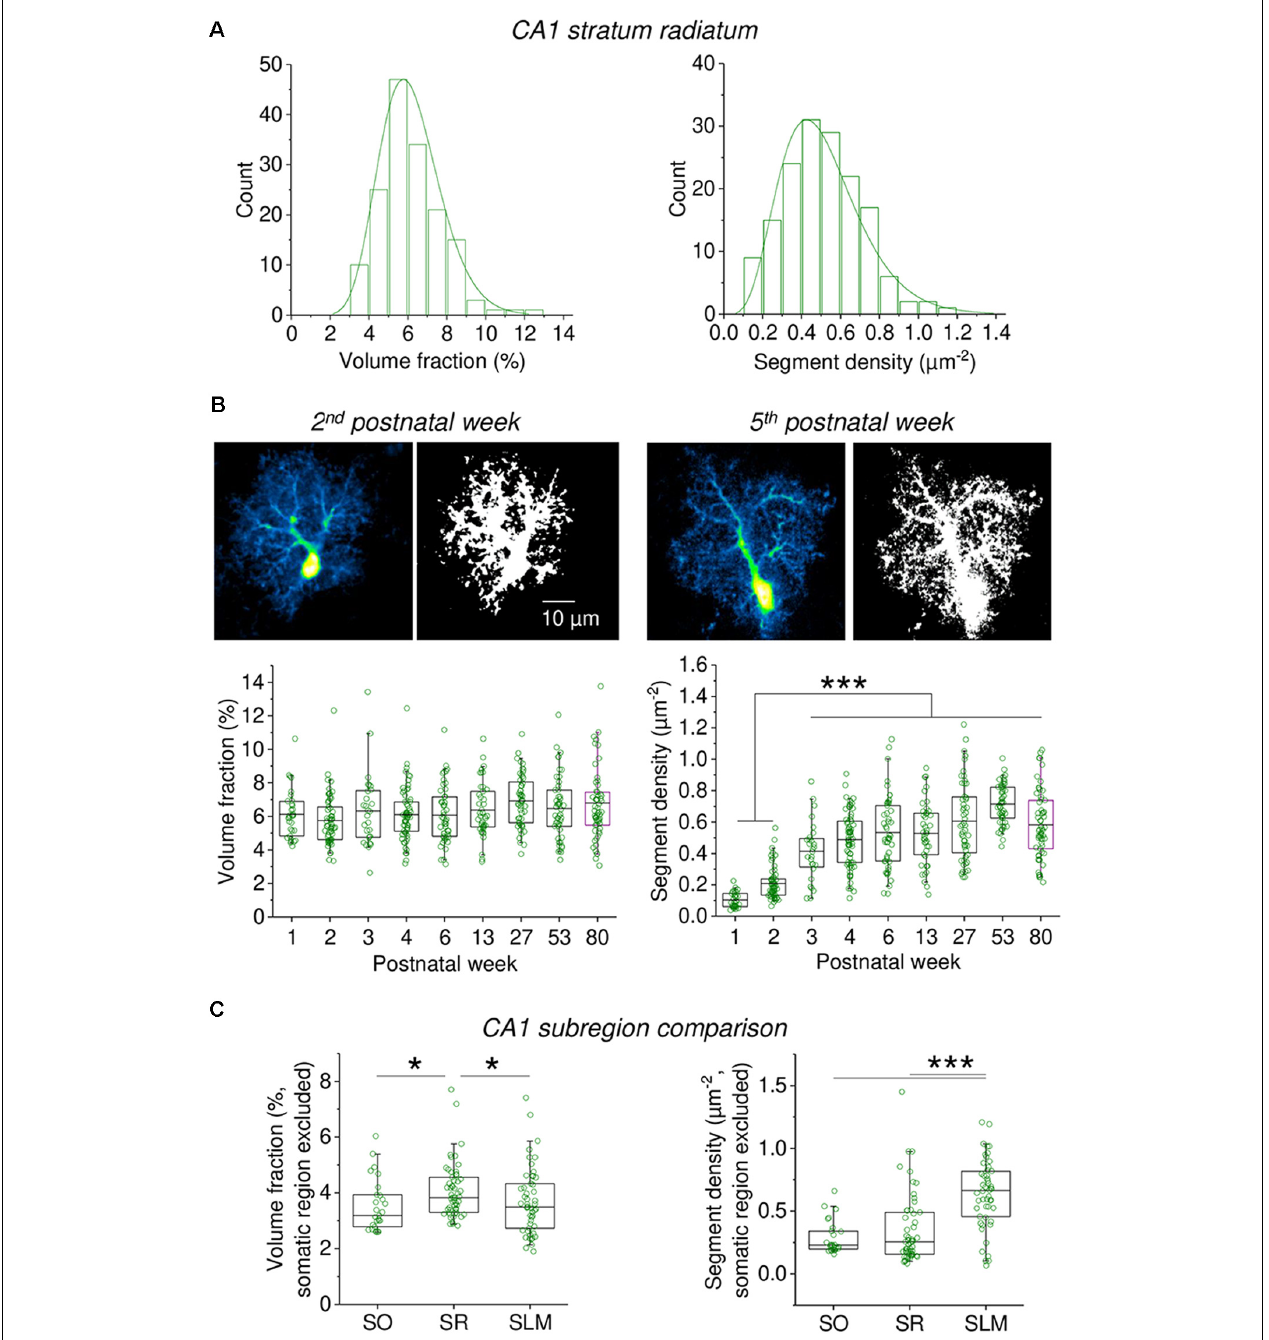
FIGURE 5 | Capturing the heterogeneity and developmental profile of astrocyte morphology using measurements of volume fraction and segment density. (A) The volume fraction and segment density of EGFP-expressing astrocytes in the CA1 stratum radiatum was analyzed in acute slices ( n = 158). Somatic reference region as before. Entire cross-sections including the soma were analyzed (see Figure 3 ). A significant heterogeneity of both parameters was observed (coefficient of variation of volume fraction = 0.26; of segment density = 0.39). (B) Developmental changes of volume fraction and segment density ( n = 437 astrocytes). Time windows in postnatal weeks and number of astrocytes from left to right: 1st n = 31, 2nd n = 59, 3rd n = 28, 4th n = 67, 5th–7th n = 49, 12th–14th n = 42, 26th–28th n = 52, 52nd–54th n = 50, 79th–81st n = 59). Like in (A) , entire cross-sections of astrocytes including the soma were analyzed (somatic reference region). Examples of astrocytes from the 2nd and 5th postnatal week are shown (top panel pairs, scale bar applies to all panels). Each image pair is a representative astrocyte shown before (left) and after (right) binarization for quantifying astrocyte segment density. Note the more granular binarized image for the astrocyte from a 5-week-old animal. See Supplementary Figure 2 for further examples. Lower panels illustrate the developmental profile. Left: volume fraction (one-way ANOVA p = 0.01846;